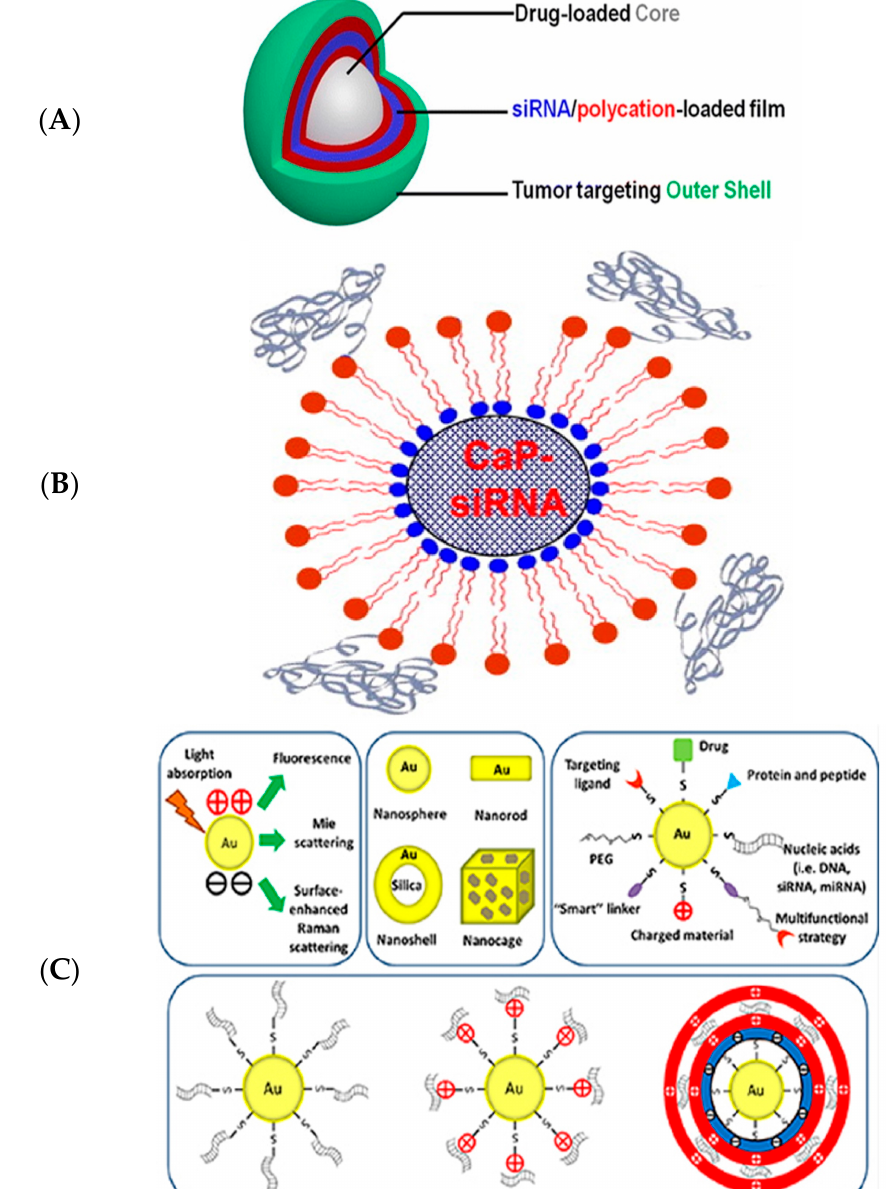
Figure 8. An LbL particle is constructed by alternative deposition of anionic and cationic components ( A ); A calcium phosphate particle stably formulates siRNA and PEG-polyanions in the core region ( B ); Thiolated siRNA is attached to Au nanoparticles and released in response of GSH (Glutathione) concentration ( C ) (Reproduced with permissions from [79–81]. Copyright ACS Nano, Elsevier and Springer, 2012, 2015 and 2013, respectively).